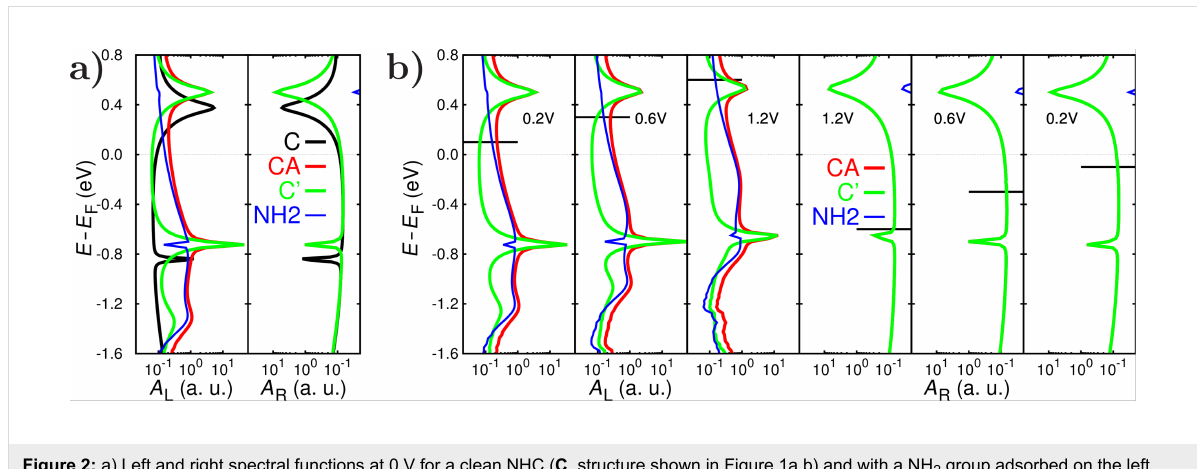
Figure 2: a) Left and right spectral functions at 0 V for a clean NHC ( C , structure shown in Figure 1a,b) and with a NH 2 group adsorbed on the left electrode, ( CA , structure in Figure 1c,d). For the latter we decompose the contributions of the carbene backbone and adsorbate ( CA = C’ + NH 2 ); b) Left (left panels) and right (right panels) projected spectral functions of the CA junction decomposed into the contributions from the NHC backbone and from the NH 2 adsorbate at 0.2, 0.6 and 1.2 V. Black, horizontal lines represent the left and right chemical potentials at different biases. NH 2 states move with respect to NHC states under bias and, at 1.2 V, there is a significant NH 2 -derived DOS above the